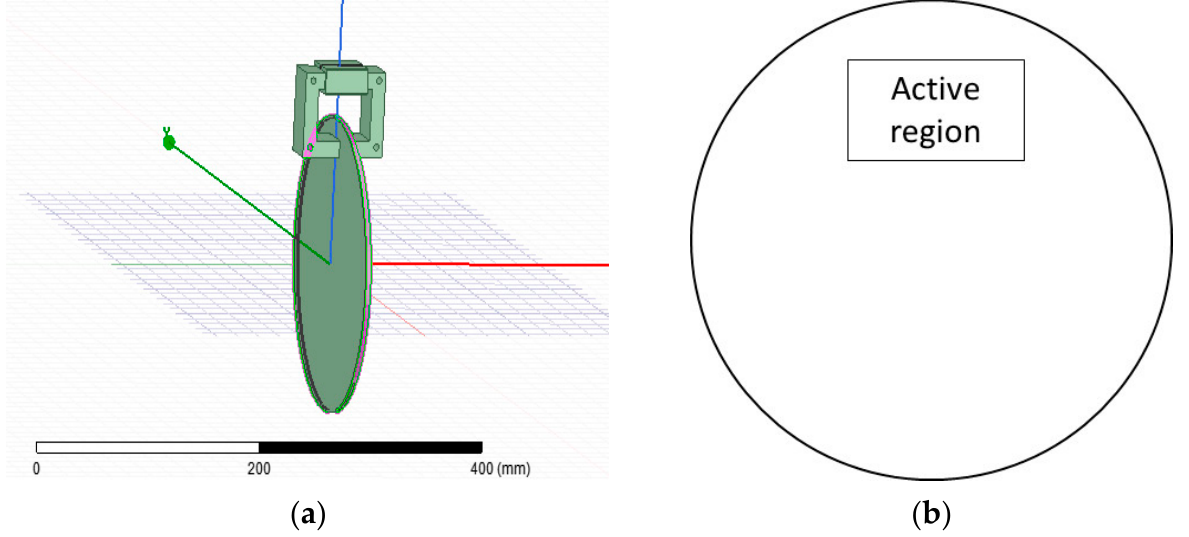
Figure 3. Eddy current brake: ( a ). domain on FEM, ( b ). Active region position.